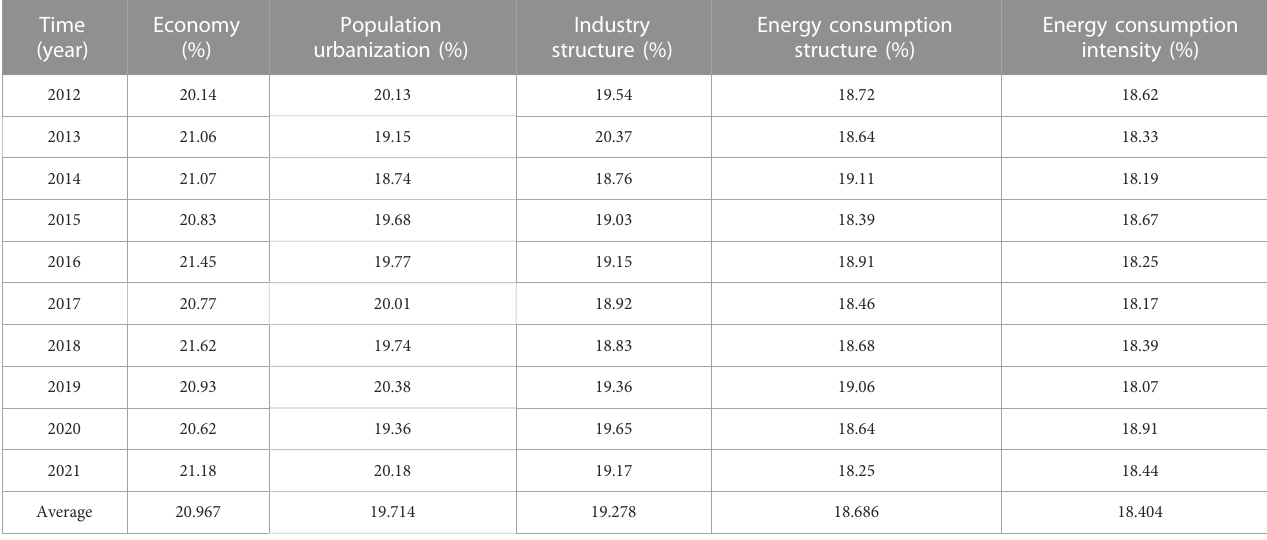
TABLE 6 Contribution rate of in fl uencing factors to carbon emissions from 2012 to 2021. Time Economy (year)